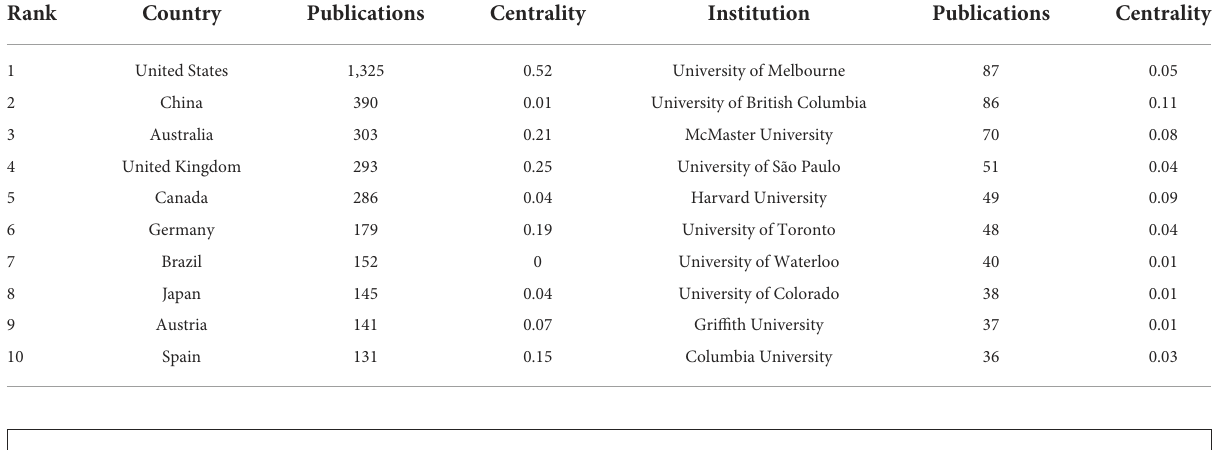
TABLE 1 Ranking of top 10 countries and institutions involved in the osteoporosis rehabilitation field.